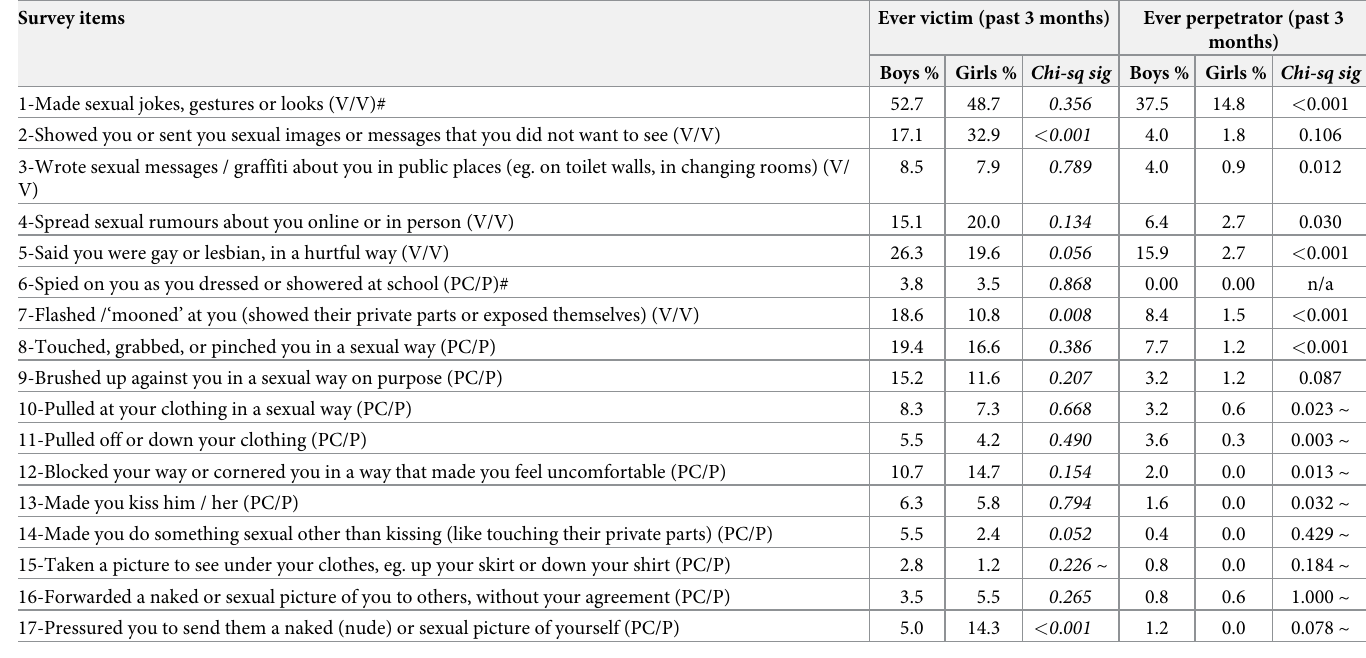
Table 1. Individual victimization and perpetration items by